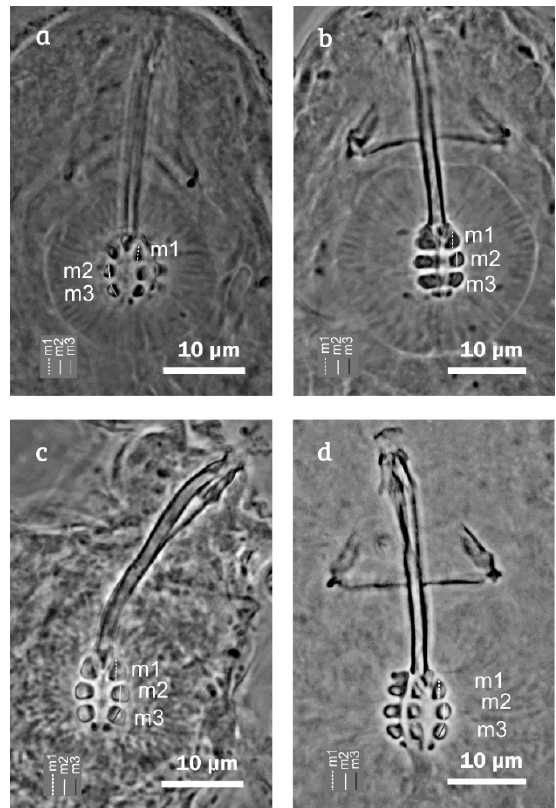
Figure 2. Minibiotus citlalium sp. nov . bucco-pharyngeal apparatus. ( a ) Paratype 2 (dorsal view, phase contrast microscopy (PCM)); ( b ) paratype 11 (dorsal view, PCM); ( c ) paratype 10 (dorsal view, PCM); and ( d ) paratype 12 (dorsal view, PCM), m1 macroplacoid 1, m2 macroplacoid 2, and m3 macroplacoid 3.